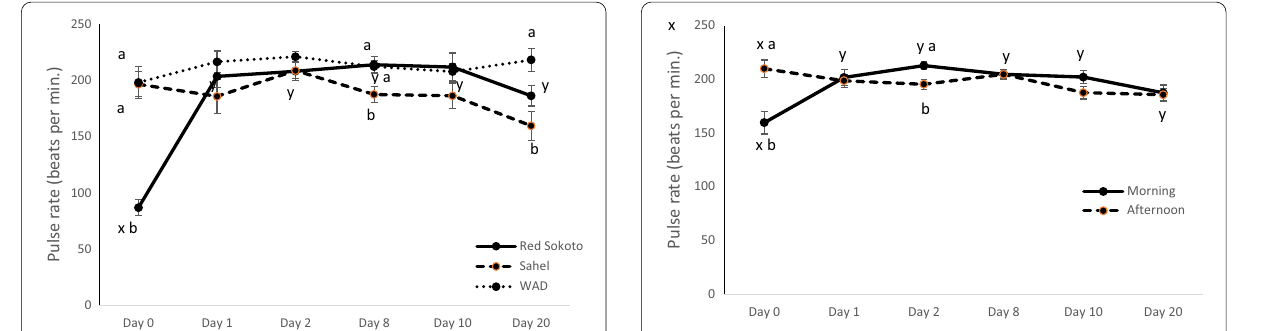
Fig. 8 Diurnal changes in pulse rate of neonatal Nigerian goats from Fig. 6 Changes in morning pulse rate in different breeds of neonatal birth to Day 20. Values with a , b and x , y indicate significant different Nigerian goats from birth to Day 20. Values with a , b and x , y indicate ( P < 0.05) between different hours of the day and ages, significantly different ( P < 0.05) between different breeds and ages, respectively The effect of breed on pulse rate of neonatal Nigerian goats is presented in Figs. 6 and 7 for morning and after- noon hours, respectively, and in Table 3 for the over- all data, irrespective of age. The pattern in the morning hours showed significant fluctuation ( P < 0.05) only in Red Sokoto kids; the patterns in other breeds showed no significant ( P > 0.05) change. A significantly lower ( P < 0.05) morning pulse rate was observed in Red Sokoto when compared with Sahel and WAD kids on the day of birth; this was followed by a marked increase ( P < 0.05) on Day 1 in Red Sokoto kids, from when the value remained stable, with no significant fluctuation until the end of the Fig. 7 Changes in afternoon pulse rate in different breeds of study. The Sahel kids had lower ( P < 0.05) morning pulse neonatal Nigerian goats from birth to Day 20. Values with a , b and x , y rate than Red Sokoto and WAD kids on Day 8 and also indicate significantly different ( P < 0.05) between different breeds and lower value than WAD kids alone on Day 20. Likewise, in ages, respectively the afternoon hours, Sahel kids had lower pulse rate than WAD kids on Days 8 and 20. Only Sahel kids showed a significant decrease in afternoon pulse rate from birth Table 3 Effects breed and sex on diurnal variation in pulse rate to Day 20 (Fig. 7). In the overall data, irrespective of age, (beats per min.) of neonatal tropical goats WAD kids had higher pulse rate than Red Sokoto and Morning Afternoon Sahel goats. Red Sokoto